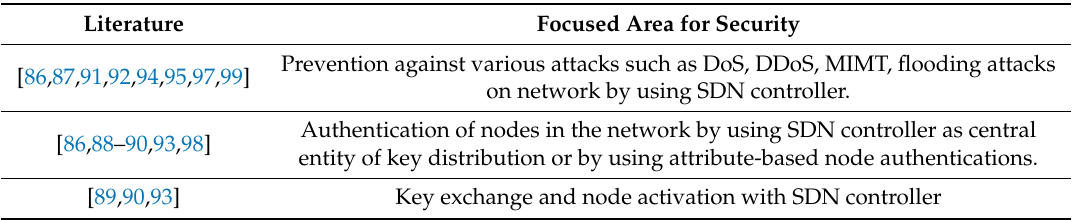
Table 4. Software defined network (SDN) applicability in various security domains. Literature Focused Area for Security Prevention against various attacks such as DoS, DDoS, MIMT, flooding attacks [86,87,91,92,94,95,97,99] on network by using SDN controller. Authentication of nodes in the network by using SDN controller as central entity of key distribution or by using attribute-based node authentications. Key exchange and node activation with SDN